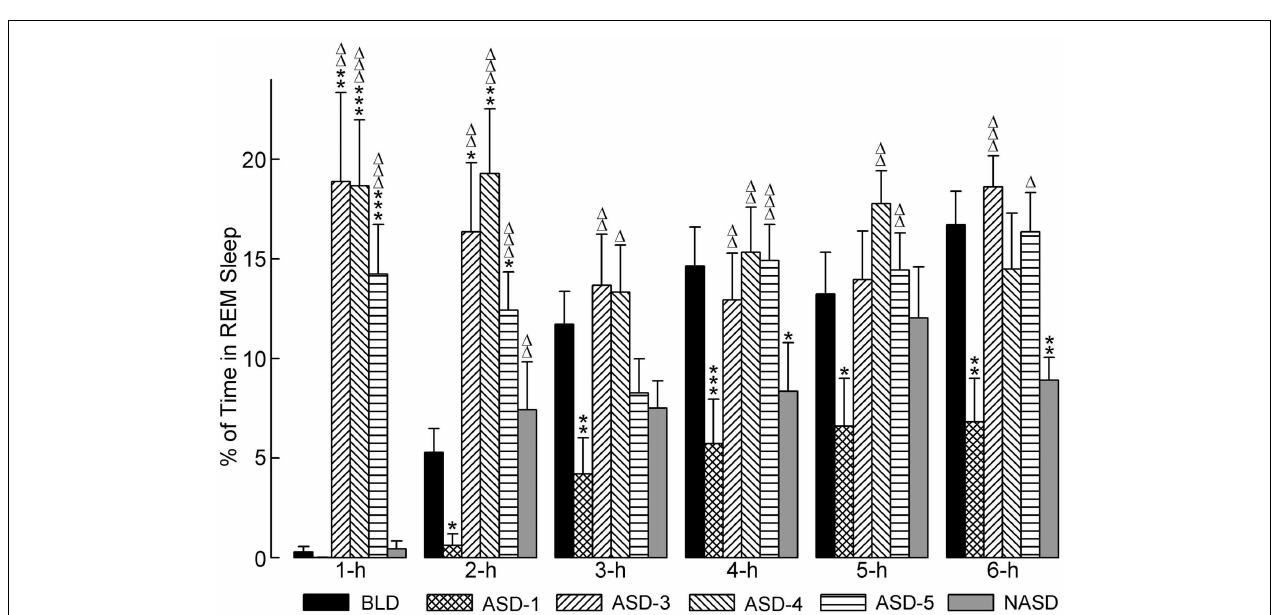
exposure (ASD-1), day 3 of AS exposure (ASD-3), day 4 of AS exposure (ASD-4), day 5 of AS exposure (ASD-5), and no exposure to AS day (NASD). *Represents a significant difference from BLD: * p < 0.05, ** p < 0.01, *** p < 0.001. ∆ represents a significant difference from ASD-1: ∆ p < 0.05, ∆∆ p < 0.01, ∆∆∆ p <